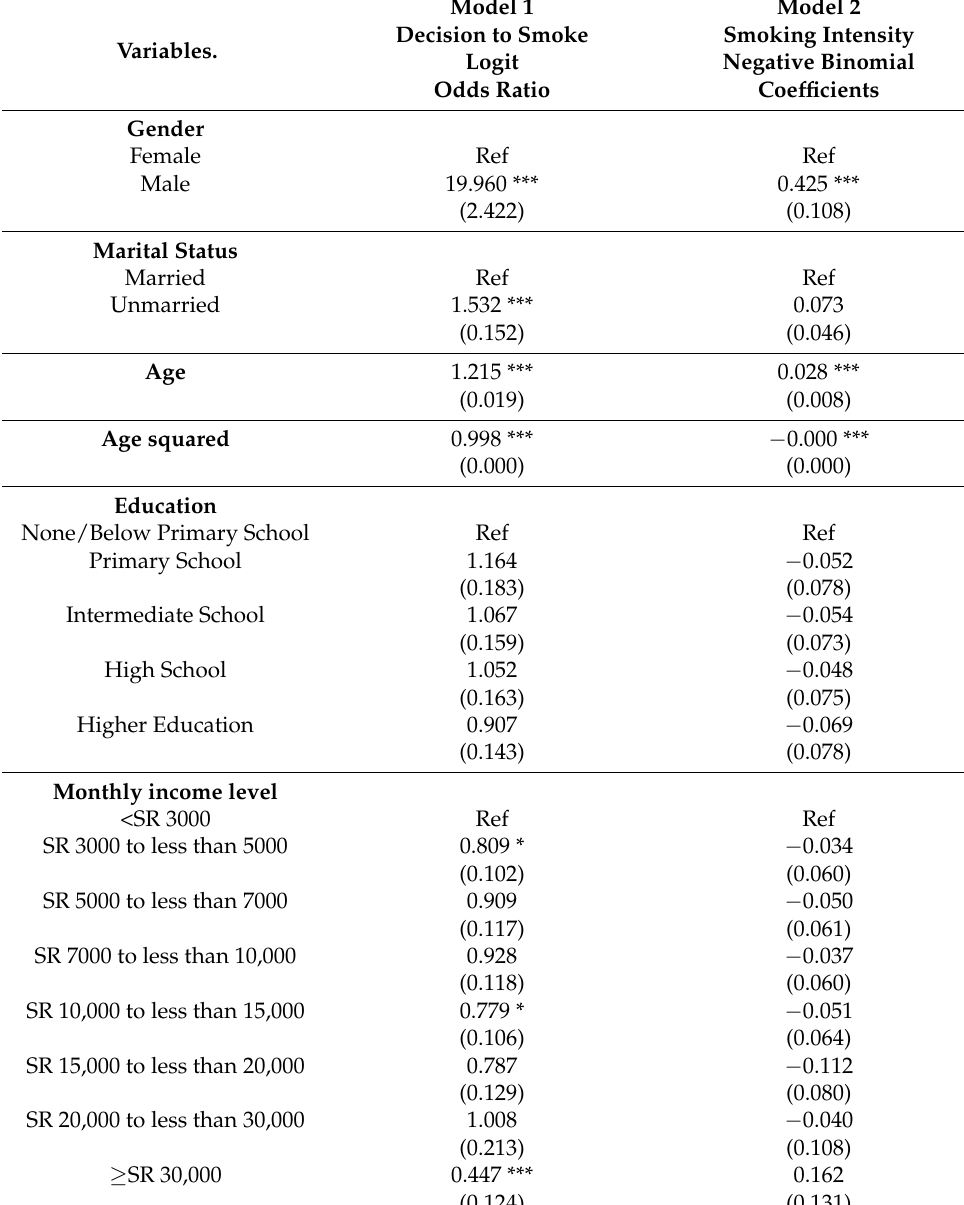
Table 4. Socioeconomic determinants of smoking and smoking intensity.